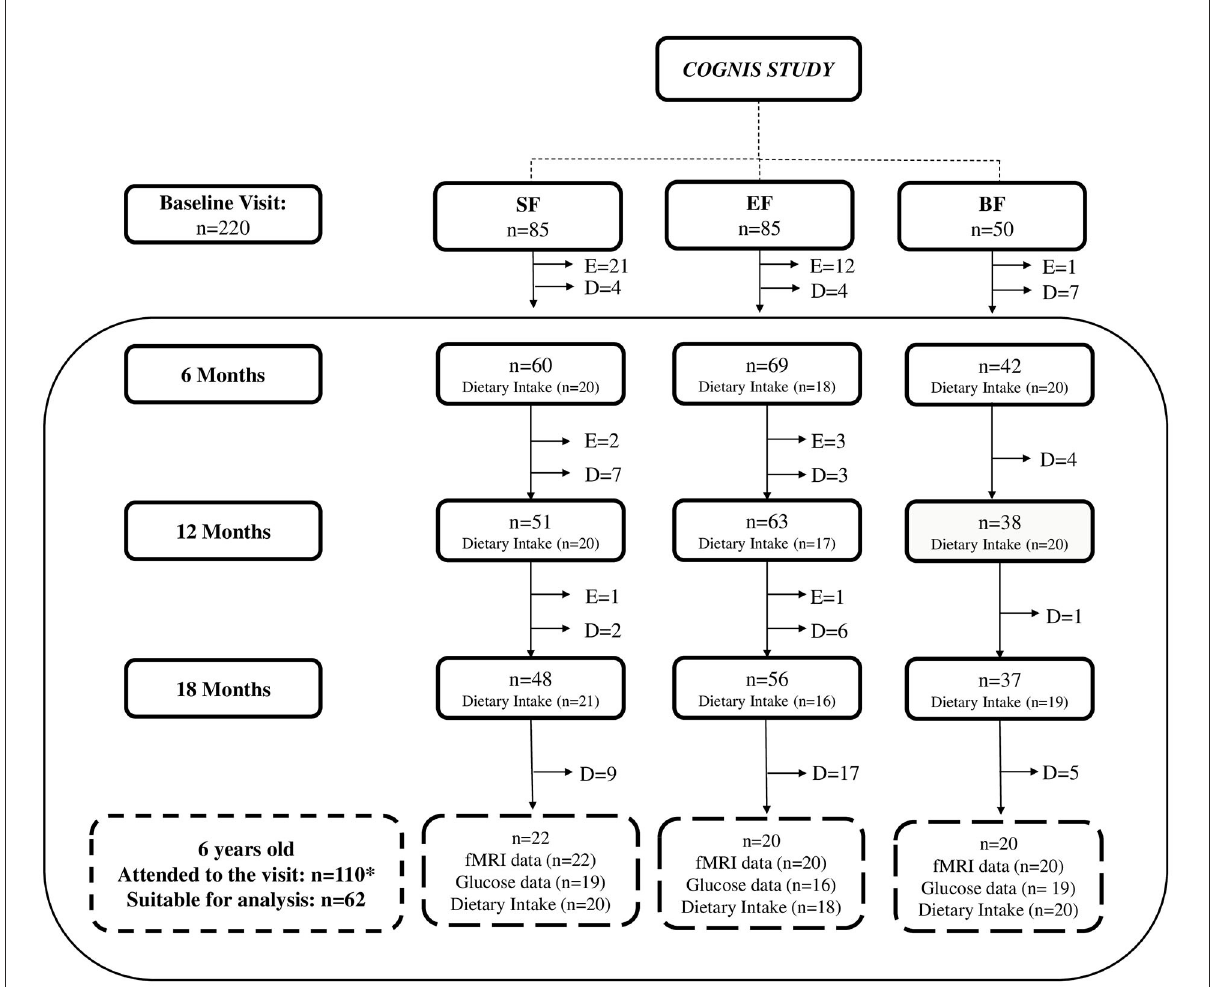
FIGURE1 Participant flowchart from baseline visit to 6 years old. BF, breastfeeding; D, dropouts; E, exclusions; EF, experimental infant formula; fMRI, functional magnetic resonance imaging; n , sample size; SF, standard infant formula. Up to 18 months of life, a total of 40 infants were excluded in the groups fed with SF and EF as follows: 24 were excluded in the SF-fed group (1 due to perinatal hypoxia, 1 had growth deficiency, not related to the infant formula, 15 did not take the infant formula, 2 had colic, 3 were excluded due to lactose intolerance, 1 was excluded due to digestive surgical intervention, and 1 suffered from hydrocephalus); 16 were excluded in the EF-fed group (2 presented growth deficiency, not related to the infant formula, 2 had lactose intolerance, 11 did not take the infant formula, and 1 was excluded due to epileptic seizure). While in the BF group, one infant was excluded, because he was not exclusively breastfed beyond the 2 months of age, when he started to take only infant formula. In the follow-up visits, drop-outs were due to participants’ parents deciding to withdraw from the study. After drop-outs, *110 children (SF: 39; EF: 39; BF: 32) attended the follow-up visit at 6 years old. Nonetheless, not all parents attending to the follow-up visit wanted their children to participate in the fMRI session or wear the 24-h continuous glucose monitoring device. Moreover, according to methodology